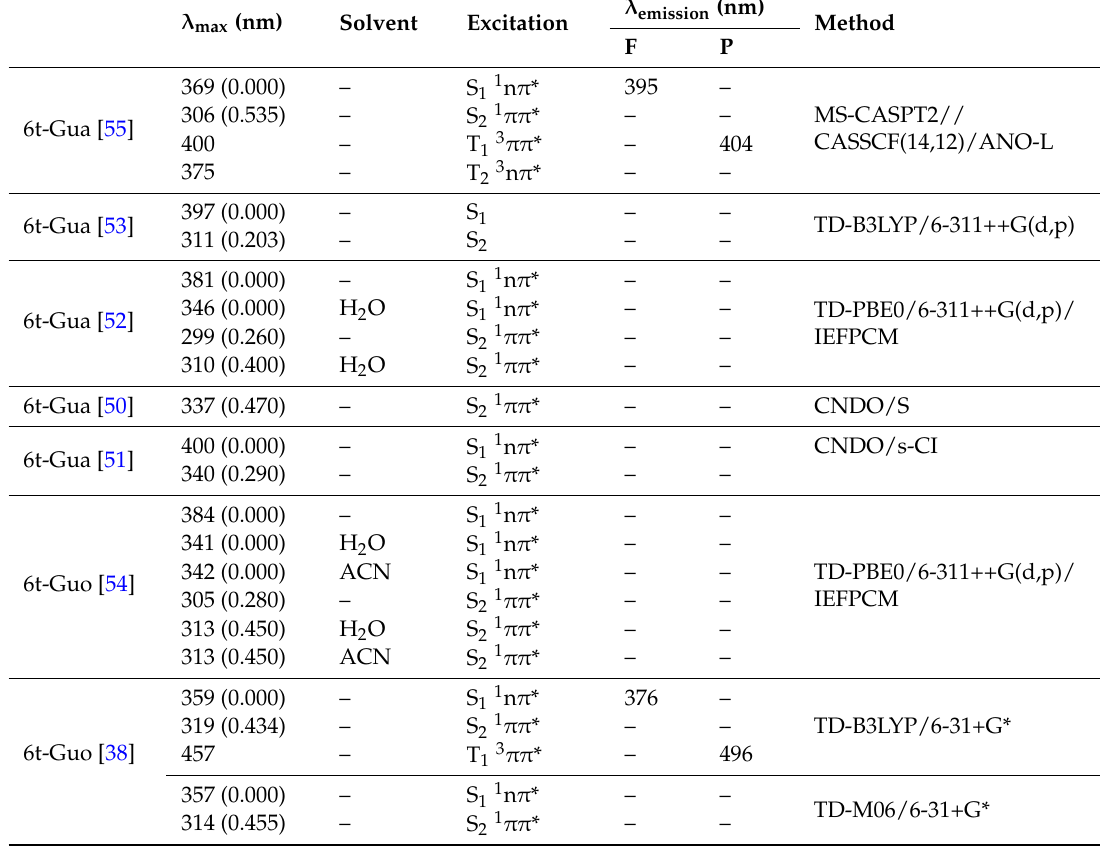
Table 2. Computed absorption and emission properties of 6-thioguanine nucleobase and nucleosides. Only information relative to the lower lying spectroscopic state and preceding electronic states is included. In parenthesis the oscillator strengths are